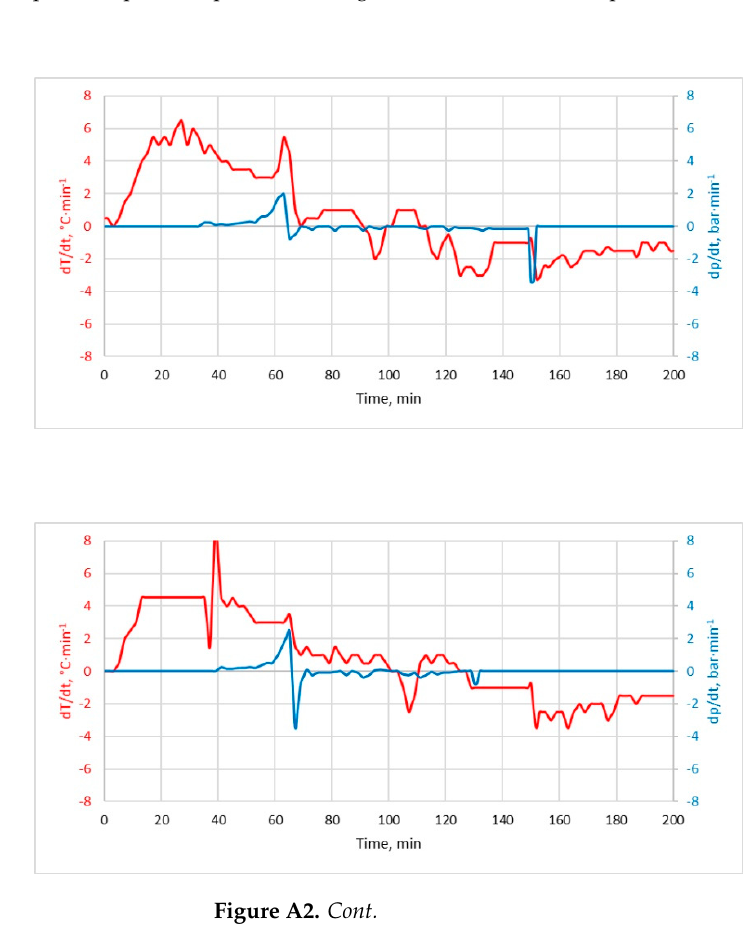
Figure A1. Temperature/pressure patterns during the torrefaction of all experiments.